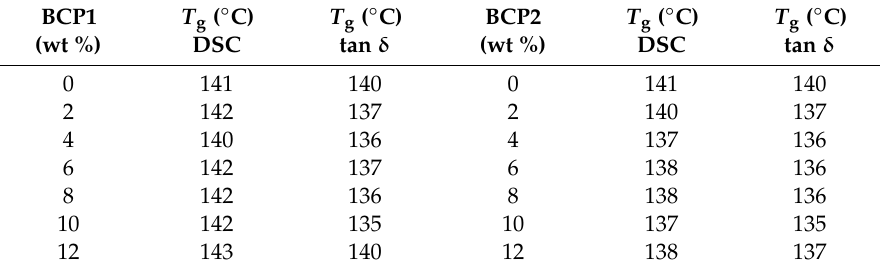
Table 2. Glass transition temperature ( T g ) of EP_BCP systems.